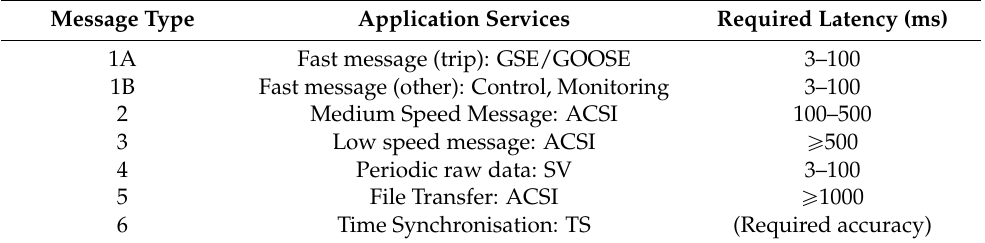
Table 1. Main IEC 61850 traffic types and timing constraints. Generic substation events: GSE; generic object oriented substation events: GOOSE; abstract communication services interface: ACSI; sampled values: